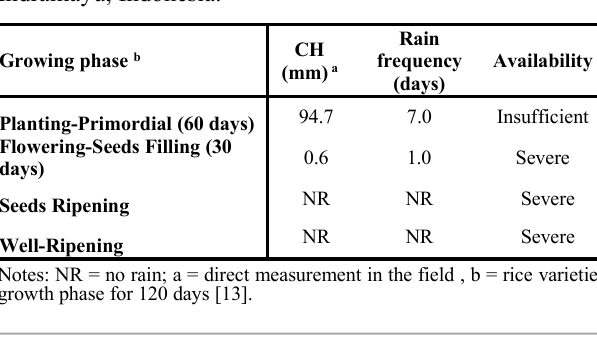
Table 2: Average rainfall during the growth of hybrid rice in the rain-fed lowland of Sanca Village, District Gantar, Indramayu, Indonesia.